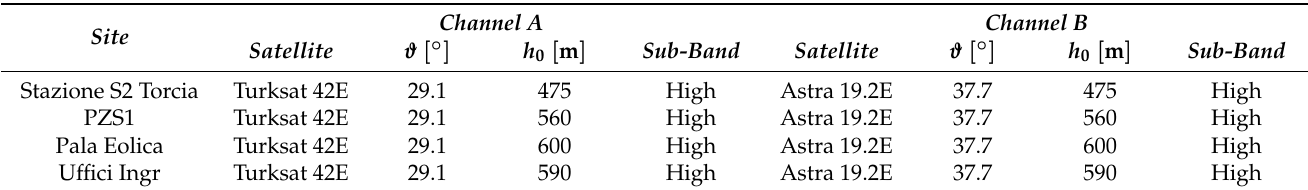
Table 1. Site’s name, reference satellite, antenna’s pointing elevation and altitude, and Ku sub-band for the SRS sensors available at the Monte Scarpino landfill.